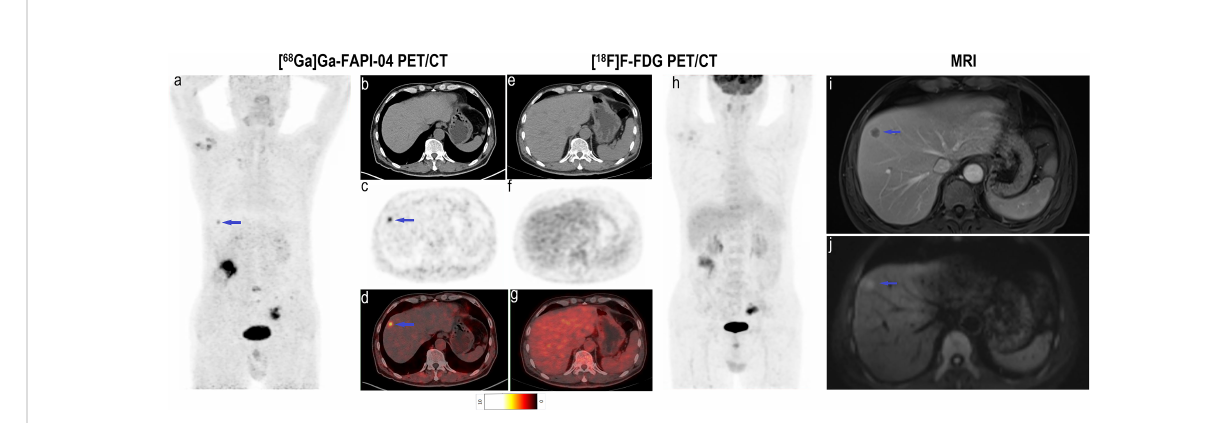
FIGURE 6 Images of a 63-year-old man with colon cancer for staging. (A) Mean intensity projection images of [ 68 Ga]Ga-FAPI-04 PET/CT scans. (B – D) Axial CT, PET and fused images of [ 68 Ga]Ga-FAPI-04 PET/CT scan. (E – G) Axial CT, PET and fused images of [ 18 F]F-FDG PET/CT scan. (H) Mean intensity projection images of [ 18 F]F-FDG PET/CT scan. (I, F) Images of contrast-enhanced MRI, T2WI (delay phase) and DWI (b = 1000). The suspicious metastatic lesion in the right liver lobe is clearly visible in [ 68 Ga]Ga-FAPI-04 PET/CT images (blue arrows in A – D ; SUV max 5.0) but absent in [ 18 F]F-FDG PET/CT images. Its presence was con fi rmed by contrast-enhanced MRI (blue arrows in I , J